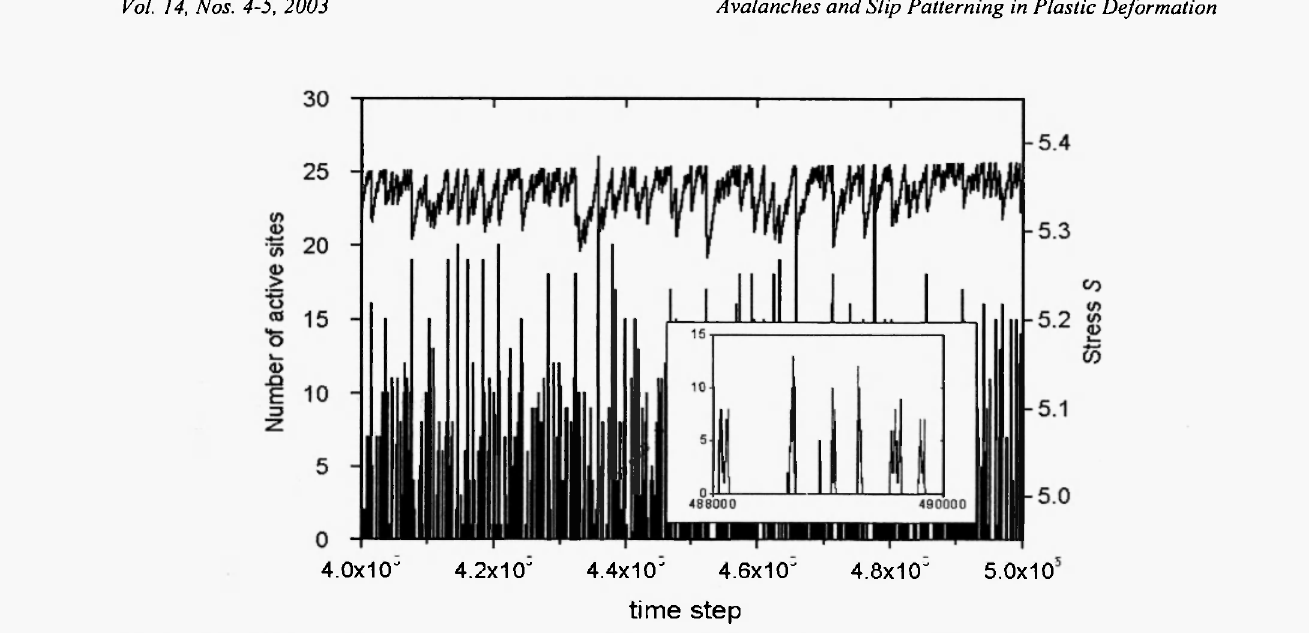
Fig. 5: Simulation of an automaton version of Eqs. (5) and (6) in the limit of zero hardening and small driving rate; parameters: number of sites Ν = 10000, yield stress S 0 = 5, machine stiffness Μ = 1/2, external strain increment per time step dK E xT = 10" 4 , local strain increment on an active site dY= 1, fluctuation strength <W 2 > = 1/3, the fluctuations are assumed Gaussian distributed; top curve: stress- time characteristics, bottom curve: 'strain rate' (instantaneous number of active sites per time step); insert: number of active sites vs. time between time steps 48800 and 49000.